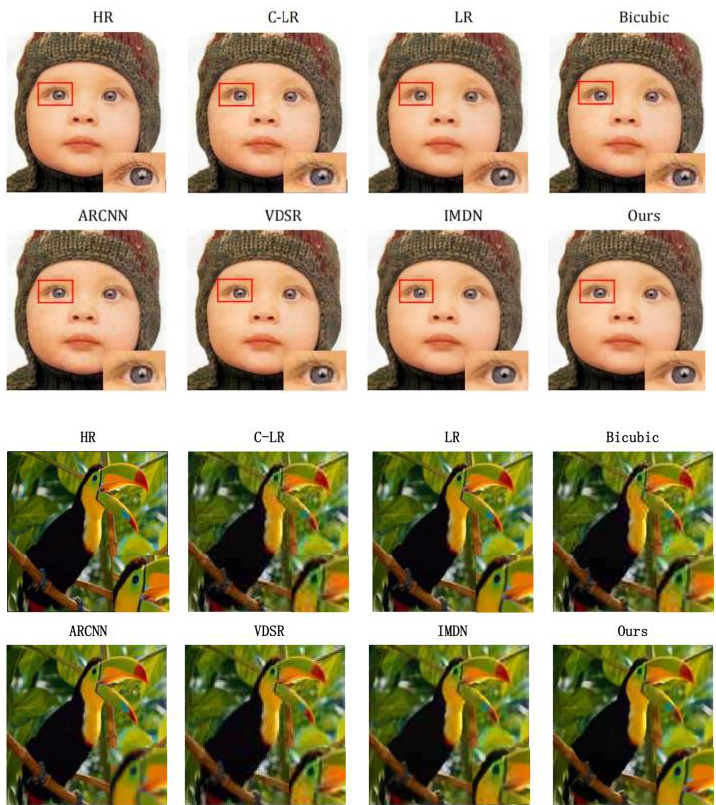
Figure 4. Visual comparison of different methods in Baby and Bird. Table 2. Comparison of the results on PSNR and SSIM in Baby and Bird.